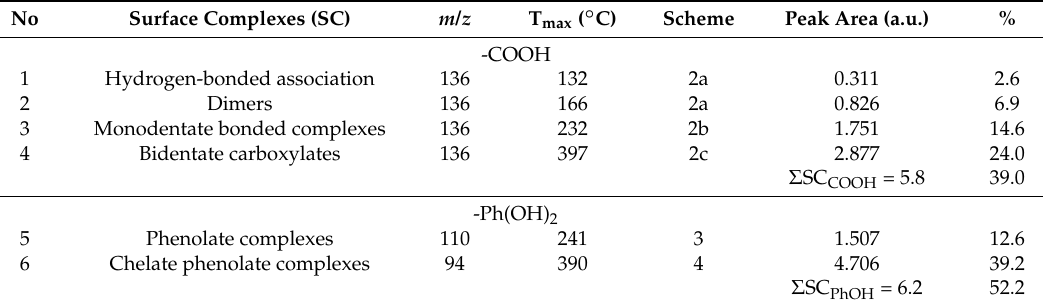
Table 3. The calculated integral intensities for the peaks of molecular ions of structurally related compounds with m / z 136 (3,4-dihydroxy-phenylethylene), 110 (pyrocatechol) and 94 (phenol). Relative content of various types of CA